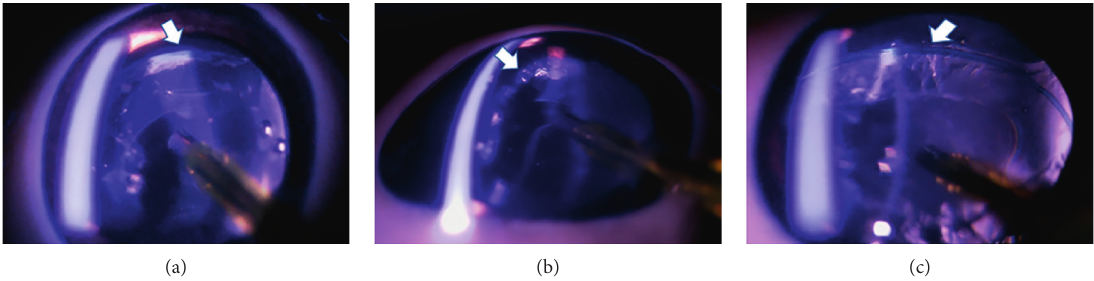
Figure 4: A CTR was inserted from the main port (arrow). The CTR was able to expand the lens and capsule and, thus, support the remaining Zinn’s zonules in the original position in the CTR group (arrow, a–c, n �